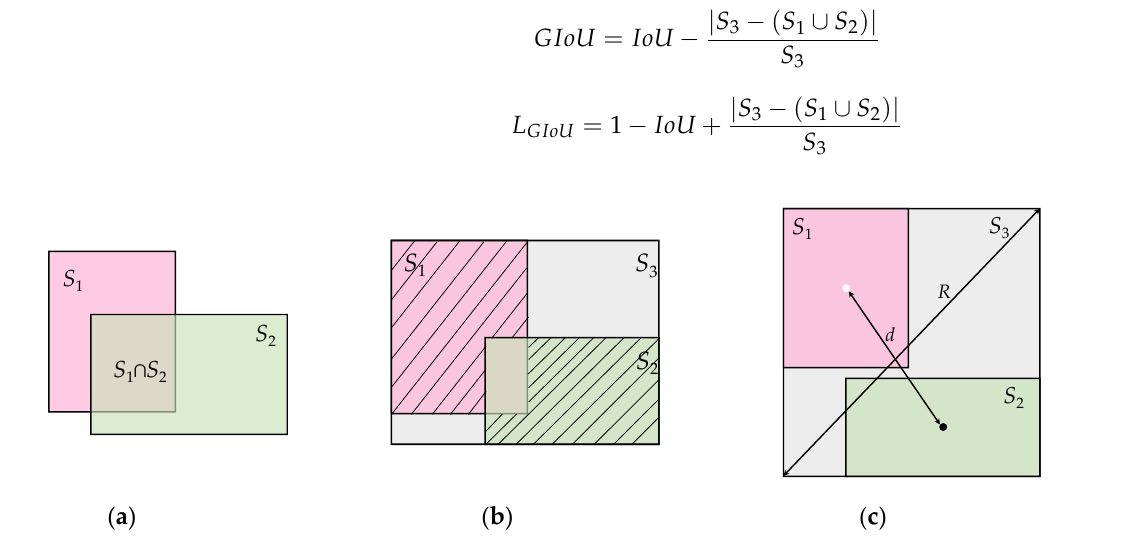
Figure 8. Schematic diagram of different intersection over union: ( a ) IoU; ( b ) GIoU; ( c )DIoU. Obviously, when the prediction box S 1 and the groundtruth S 2 do not overlap, i.e., IoU = 0, the value of GIoU is not zero, ensuring that the gradient of the loss function can be propagated backwards. However, when S 1 contains S 2 , GIoU degenerates to IoU and the exact regression calculation cannot be implemented through both GIoU and IoU . Therefore, DIoU is introduced and its visualization is shown in Figure 8c. Constraints on the distance between the centers of the two boxes S 1 and S 2 are incorporated in the regression process through DIoU to better characterize the overlap information, which is calculated as: